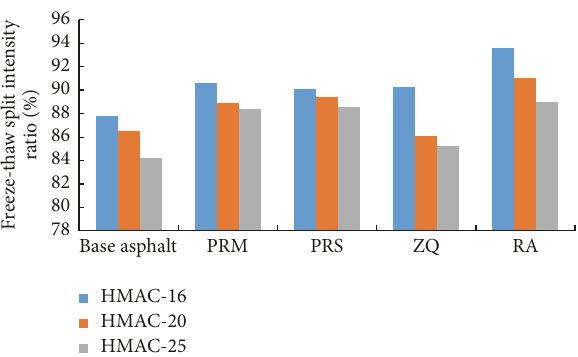
Figure 13: Freeze-thaw split intensity ratio of HMAC.